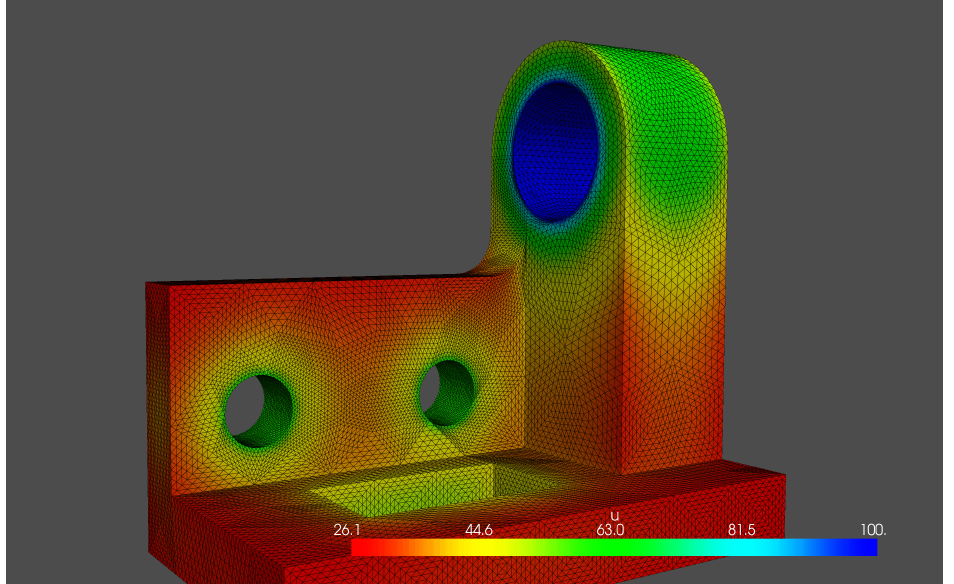
Figure 5. Temperature contour of a function space of order 2.